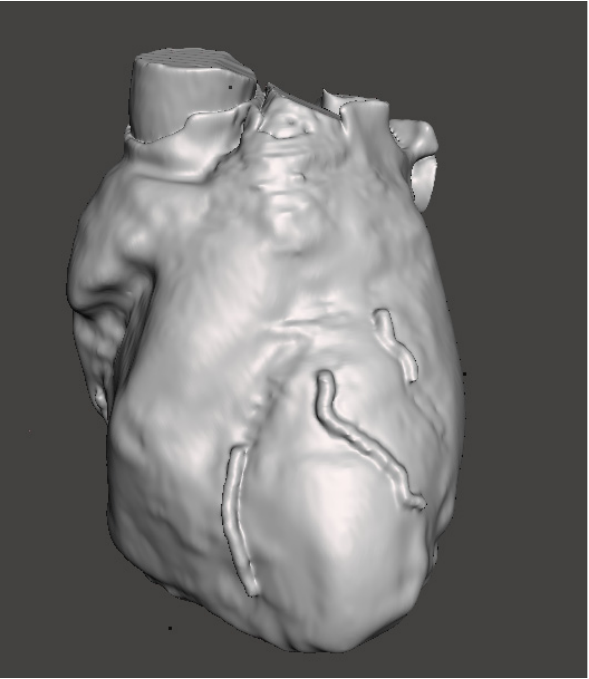
Figure 3. Heart model with selected region of interest.